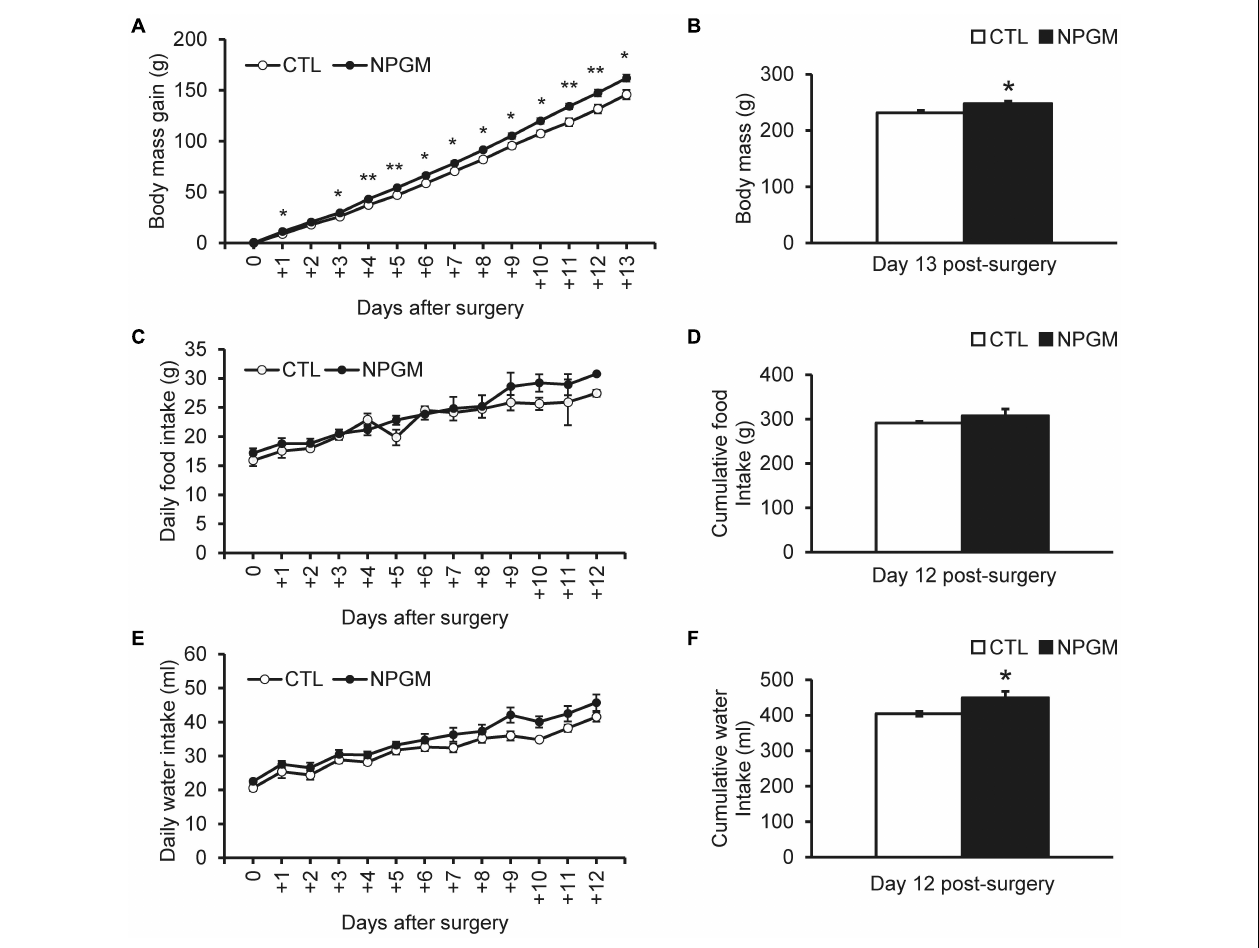
FIGURE 1 | Effect of chronic i.c.v. infusion of NPGM on body mass gain, food intake, and water intake. The results were obtained by the infusion of the vehicle (control; CTL) and NPGM. The change in the body mass gain after surgery (A,B) . The daily and cumulative food intake (C,D) . The daily and cumulative water intake (E,F) . Data are expressed as the mean ± SEM ( n = 7–8). Data were analyzed using the student t -test and two-way repeated-measures analysis of variance (ANOVA). An asterisk indicates a statistically significant difference (* P < 0.05, ** P <